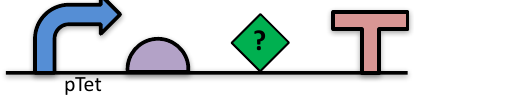
Figure 36: DNA sequence with three primer binding sites.